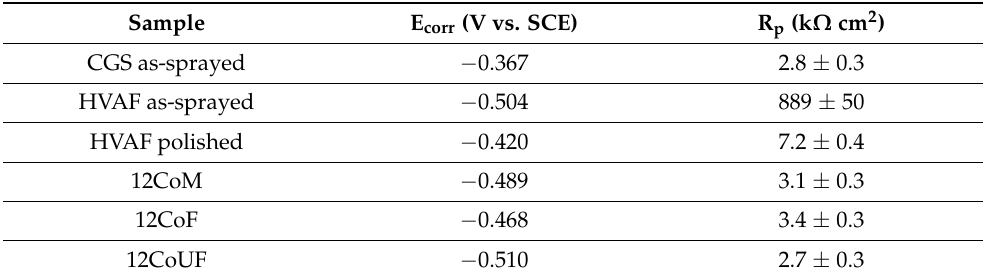
Table 3. Corrosion potential (E corr ) and polarization resistance (R p ) for the different samples in 3.56 wt% NaCl solution at 25 ◦